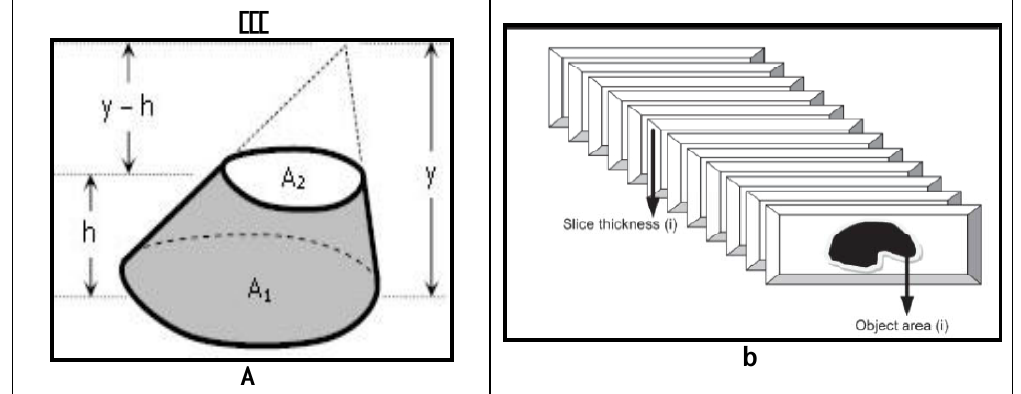
Fig. 5: Show (a) the frustum model, (b) the CT Slices